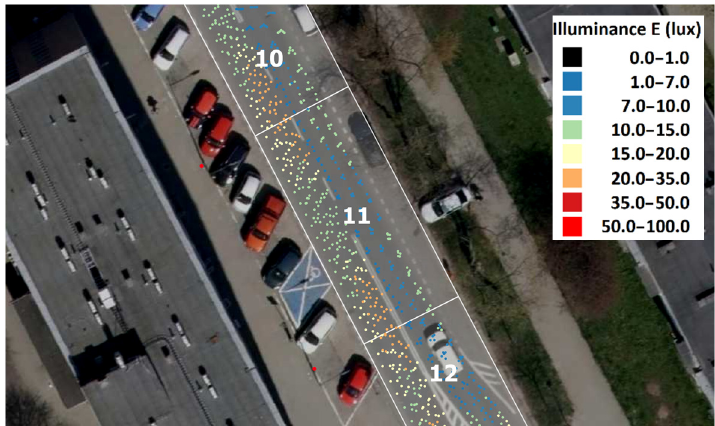
Figure A7. Example of five illuminance measurements in field No. 11.